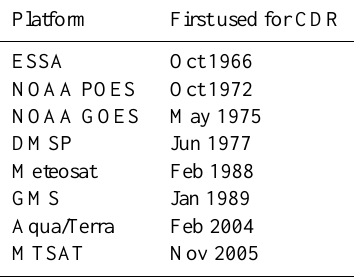
Table 1. Satellites and date of incorporation into snow map- ping analysis for the NH SCE CDR. Primary platforms in- clude the Environmental Science Services Administration (ESSA) series, NOAA Polar-orbiting Operational Environmental Satel- lites (POES), NOAA Geostationary Operational Environmental Satellites (GOES), the Defense Meteorological Satellite Program (DMSP) series, the Meteosat series, Geostationary Meteorological Satellites (GMS), Aqua, Terra, and the Multi-functional Transport Satellites (MTSAT).